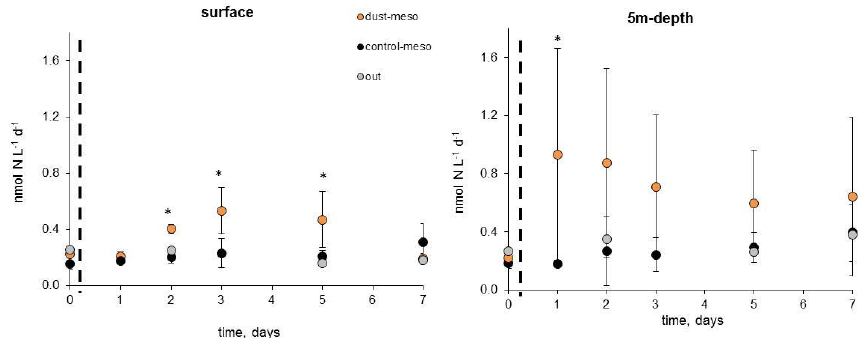
Fig. 2. Mean N 2 fixation rate ( n = 3) in nmol NL − 1 d − 1 during the DUNE-1-Q experiment in the Control-meso (black dot), Dust-meso (orange dot) and Out (grey dot) at surface and 5m depth. The dotted line represents the time of the dust seeding. Data in the Control- and Dust-meso represent the average and standard deviation of the three replicate mesocosms. Means in the Dust-meso that were significantly different ( p <0.05) from the Control-meso are labeled with the *